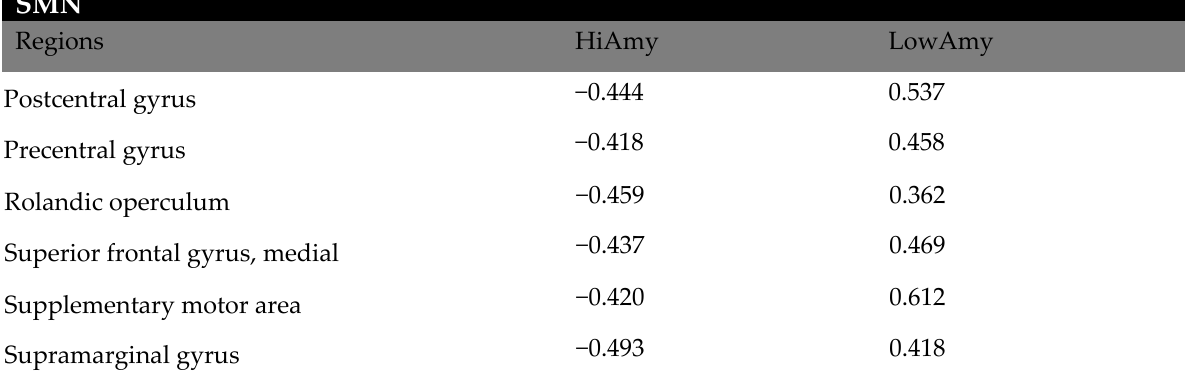
Figure 7. Correlation between A β burden and IFC in